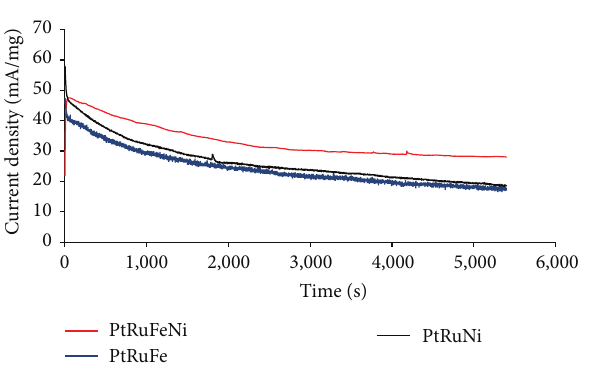
Figure 7: Chronoamperometry curves for (a) PtRuFeNi/MWCNT, PtRuFe/MWCNT, and PtRuNi/MWCNT in a 0.5 M H 2 SO 4 + 1M CH 3 OH solution.